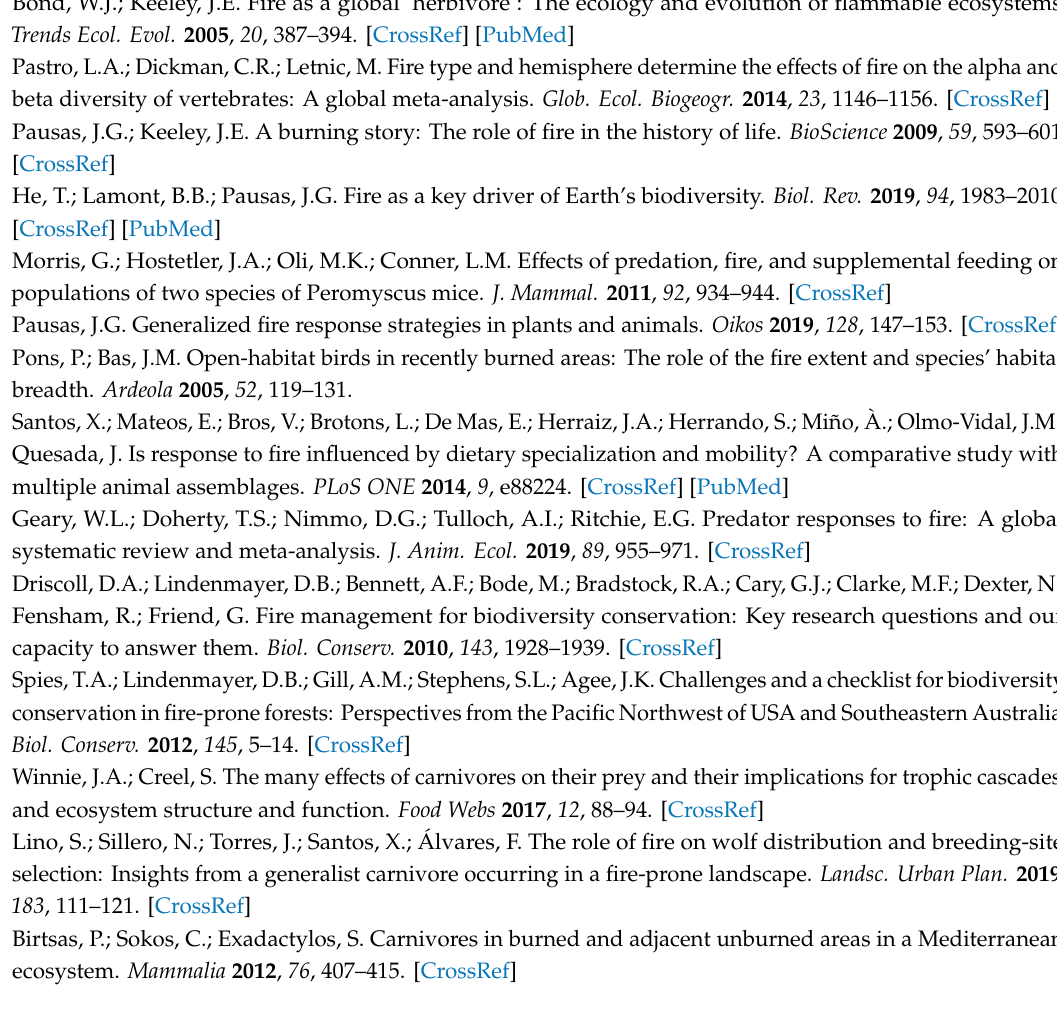
Figure S1: Principal component analysis of habitat structure, Table S1: Selected GLMM models and criteria, Text S1: Structural Equation Modelling